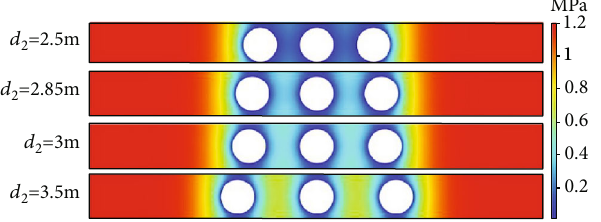
Figure 4: Gas pressure distribution in coal matrix under di ff erent slot spacing d 2 after 15-day extraction.